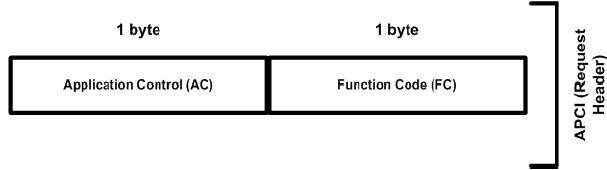
Figure 3. Request header structure.